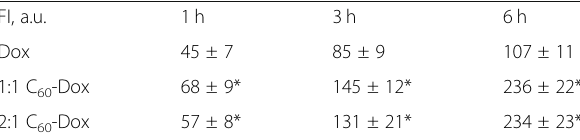
Table 2 Mean fluorescence intensity (FI) of intracellular accumulated Dox estimated by FACS histograms FI, a.u. 1 h 3